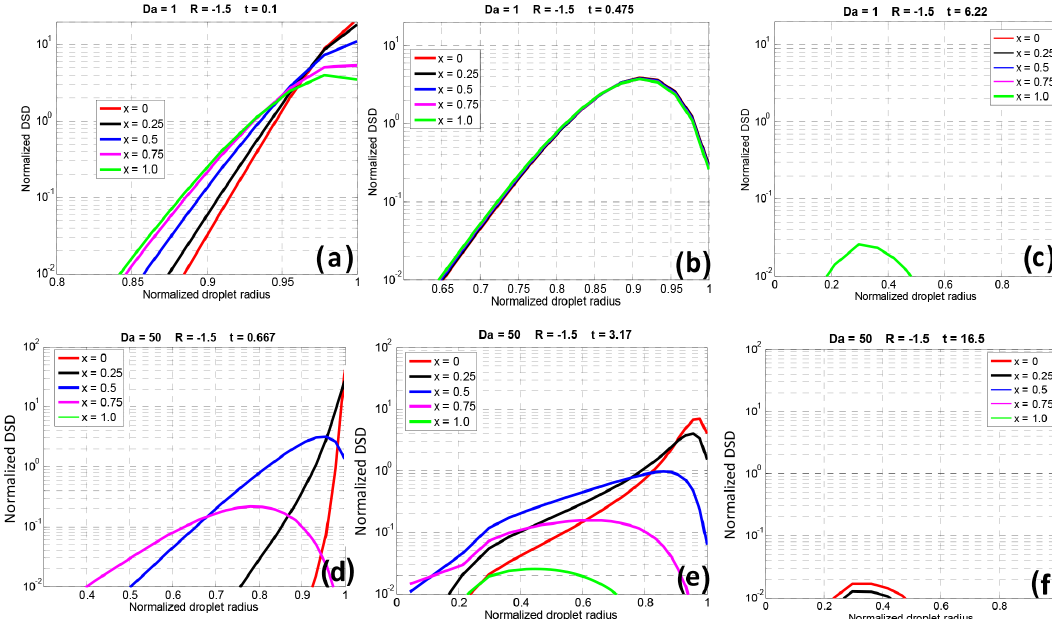
Figure 6. Time evolution of DSD during droplet evaporation at Da = 1 (upper row) and Da = 50 (bottom row). In each panel, the normalized DSD are shown at different values of horizontal coordinate e x . Different panels show DSD at different time